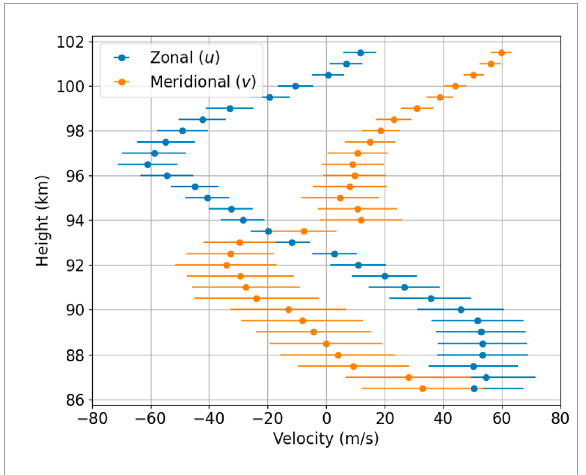
FIGURE 10 Estimated zonal and meridional wind velocity as a function of height, which is derived by combining the Sodankylä and Andenes meteor radar measurements of line of sight